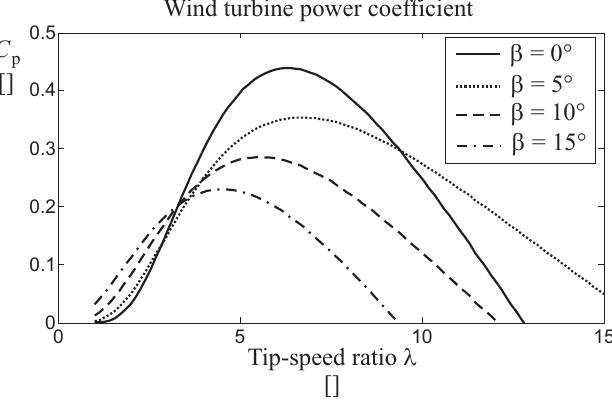
Figure 2. Example of power coefficient function C p ( β , λ )